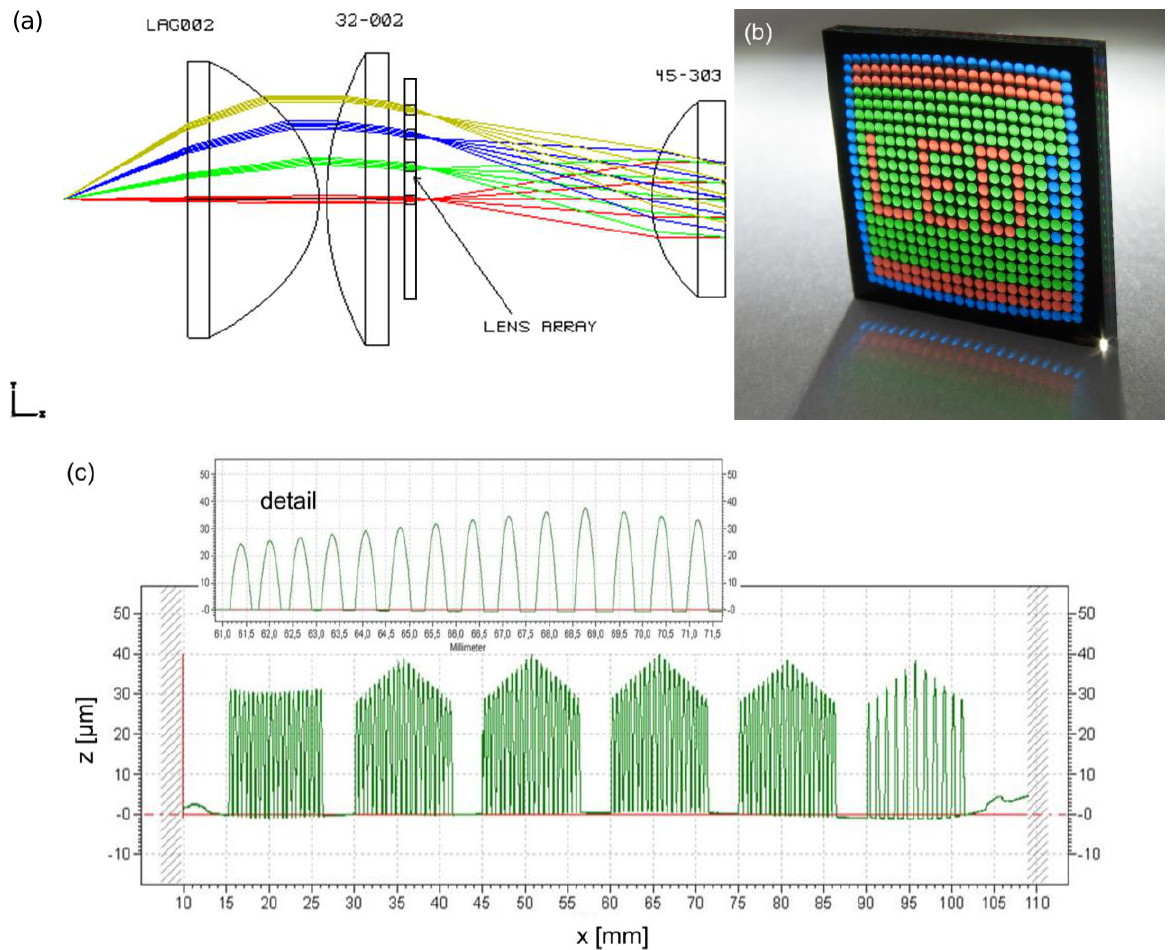
Figure 7. LED illuminated array of 21 × 21 spots ( a ) configuration consisting of LED, condenser, chirped lens array and relay lens; ( b ) photograph of a separated chirped lens array including apertures and filters; ( c ) measured surface profile across a regular array and chirped arrays. Detail resolves single